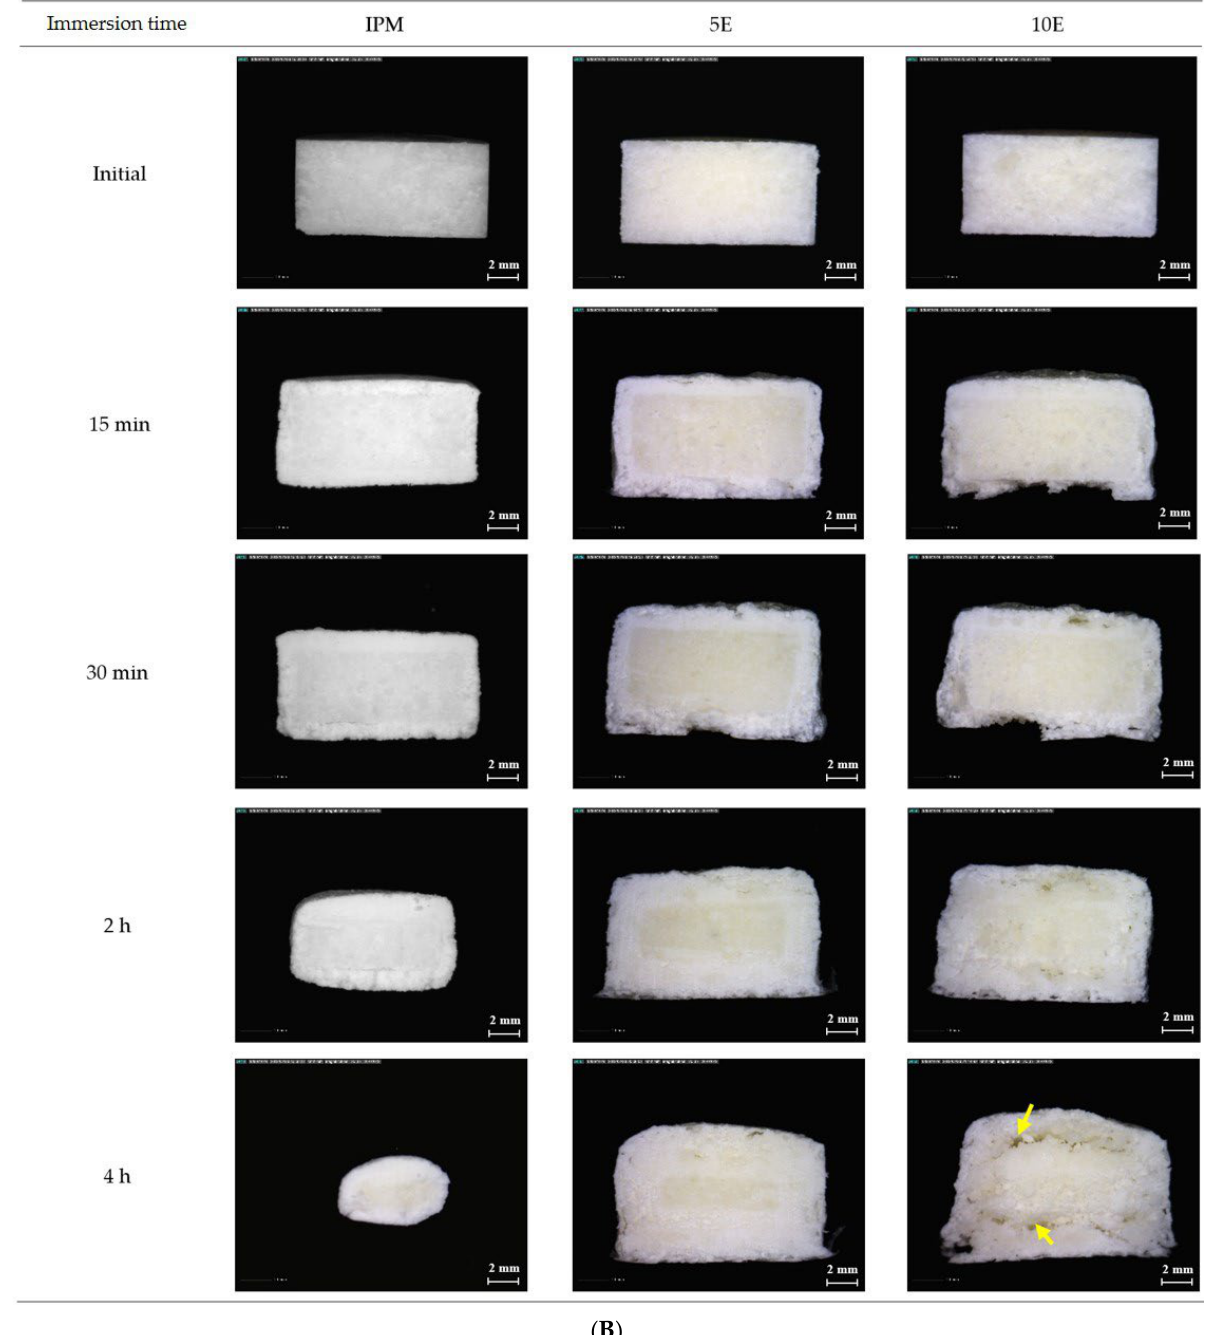
Figure 5. ( A ) Surface and ( B ) cross-sectional micrographs of IBU-P407 effervescent matrix tablets in pH-changed media at various immersion times (magnification: 26.8×) .